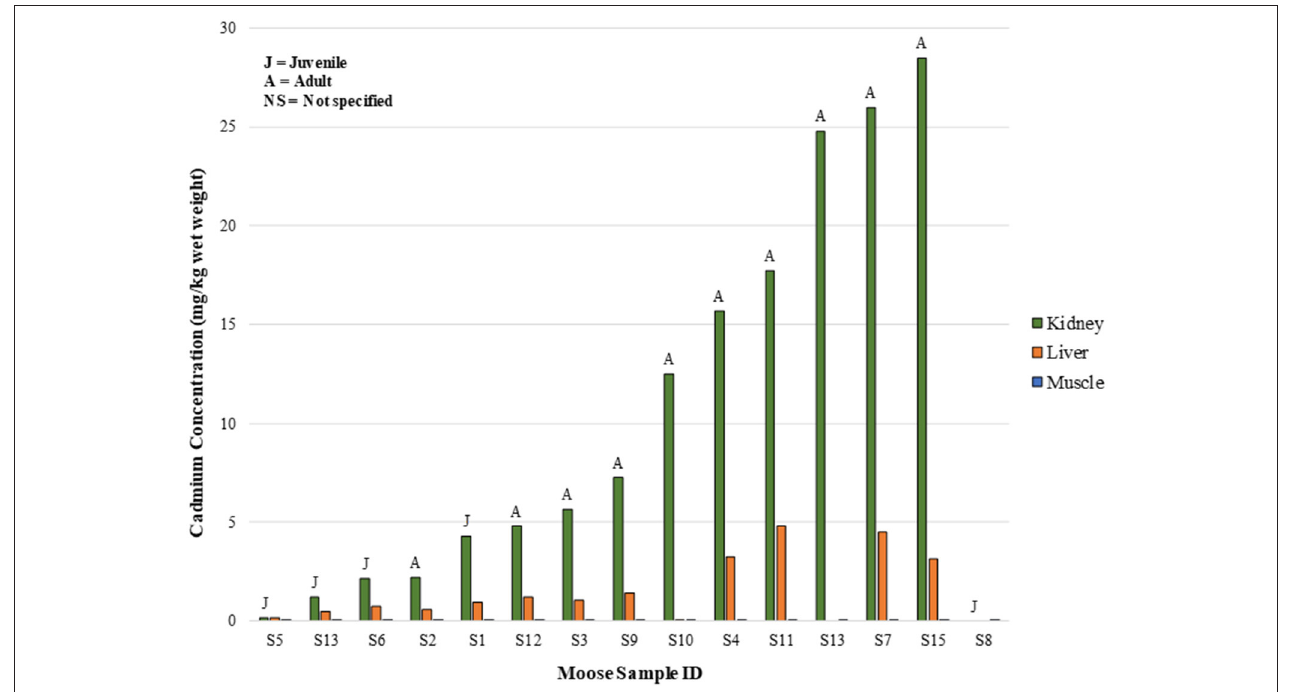
FIGURE 4 | Moose tissue concentrations - SRFN.